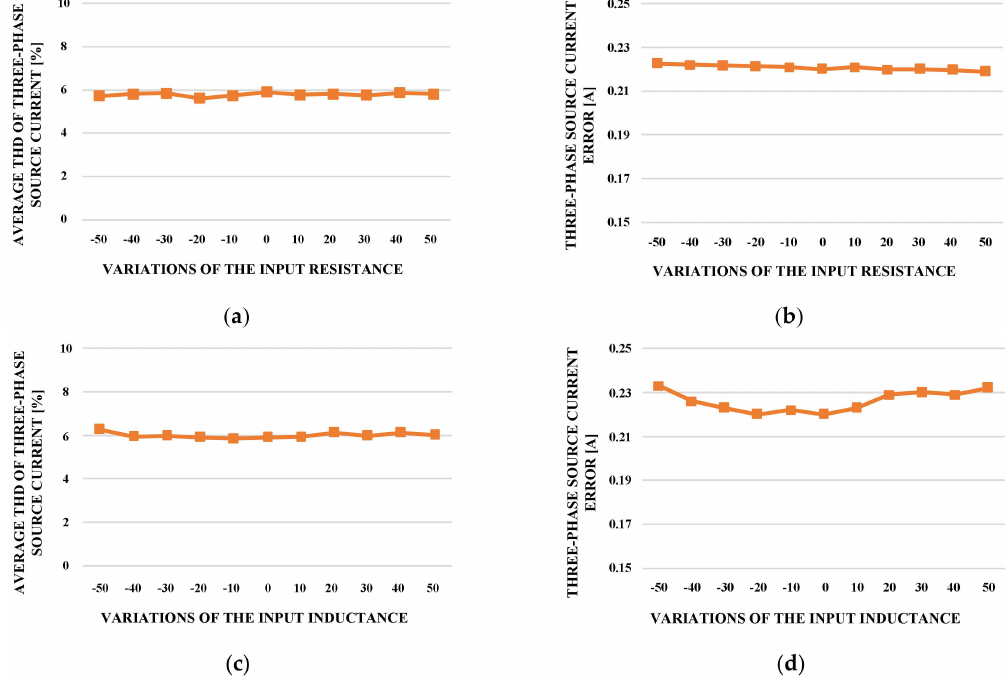
Figure 16. Comparison results: ( a ) Average THD of three-phase source current, ( b ) current error versus model errors in input resistance, ( c ) average THD of three-phase source current, and ( d ) current error versus model errors in input